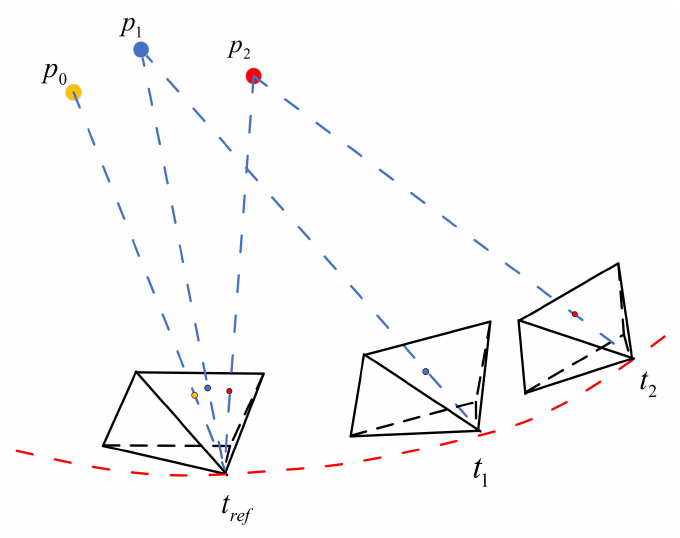
Figure 3. Motion compensation of event